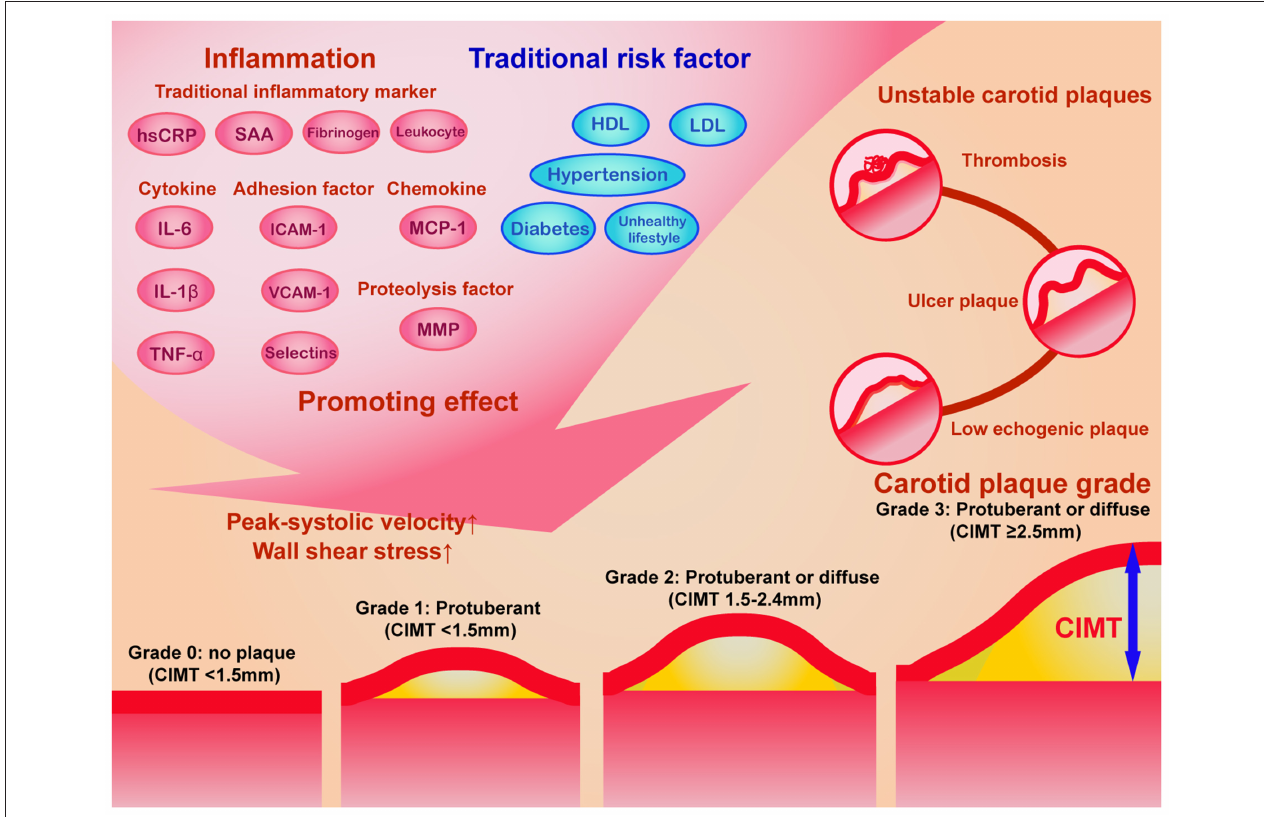
FIGURE 3 | The schematic diagram of the impact of inflammation and traditional risk factor on carotid plaque progression and the grading system of carotid plaques. Traditional inflammatory markers, cytokines, chemokines, adhesion factors, proteolysis factors, and other novel inflammatory factors, in combination with traditional risk factors promotes elevated carotid plaque grade and unstable carotid plaques. According to Recommendations for the Assessment of Carotid Arterial Plaque by Ultrasound from the American Society of Echocardiography in 2020 (41), the carotid plaque grade was classified into 4 levels: grade 0 (no plaques with CIMT < 1.5mm), grade 1 (protuberant CIMT < 1.5mm), grade 2 (protuberant or diffuse CIMT between 1.5 and 2.4mm), and grade 3 (protuberant or diffuse CIMT ≥ 2.5mm). The ultrasound characteristics of unstable carotid plaques includes low echogenic plaques, ulcer plaques, and thrombosis. CIMT, carotid intima-media thickness; HDL, high-density lipoprotein; hsCRP, hypersensitive C reactive protein; ICAM-1, intercellular cell adhesion molecule-1; IL-6, interleukin-6; IL-1 β , interleukin-1 beta; LDL, low-density lipoprotein; MCP, monocyte chemotactic protein-1; MMP, matrix metallopeptidase; TNF- α , tumor necrosis factor-alpha; VCAM-1, vascular cell adhesion